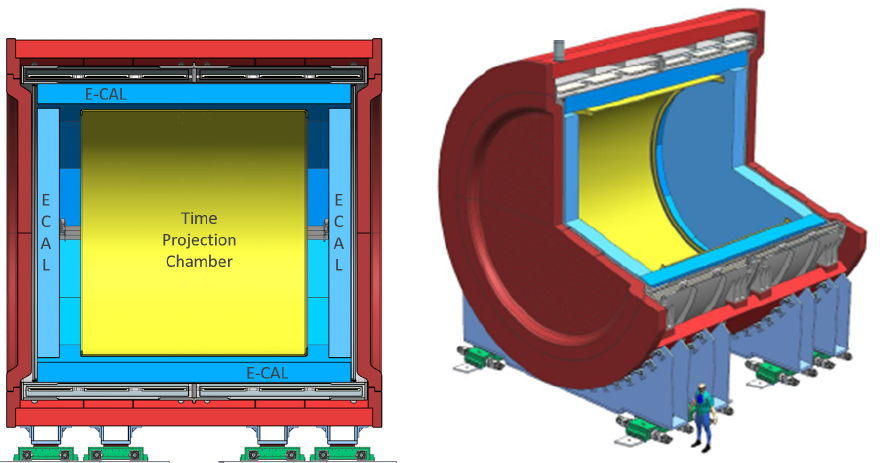
Figure 1. Cross-section of the ND-GAr detector and SPY